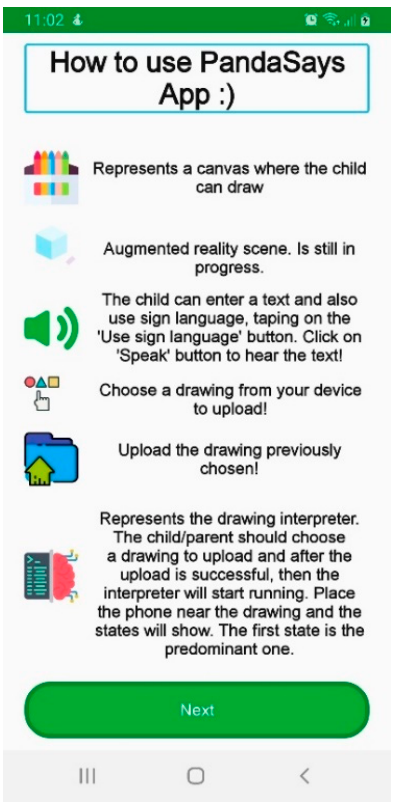
Figure 8. PandaSays UserManul screen with TalkBack on.